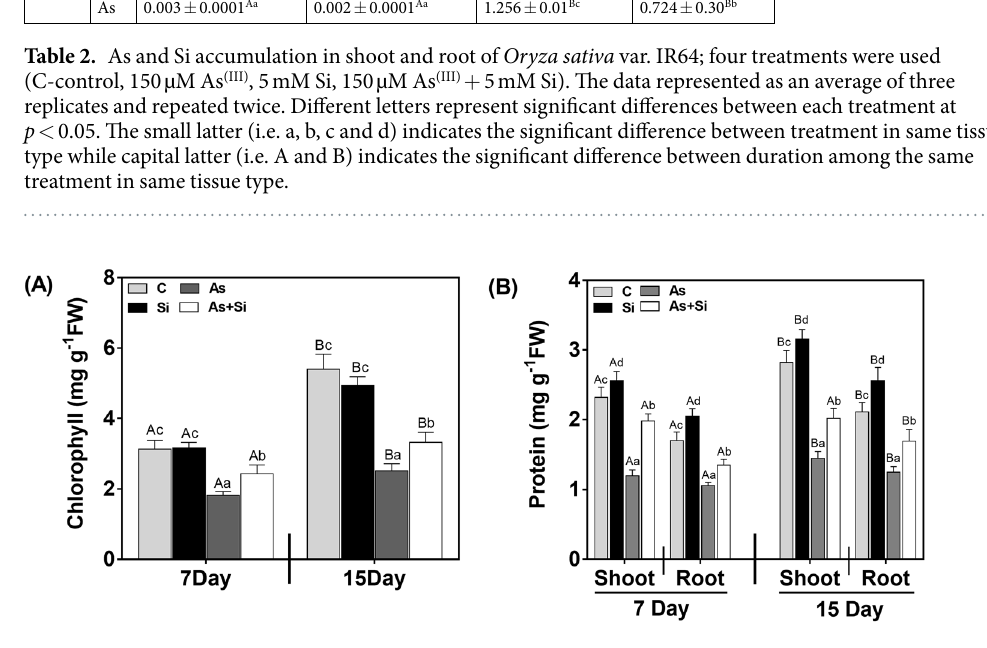
Figure 1. Effect of Si supplementation on ( A ) chlorophyll ( B ) protein content in shoot and roots of Oryza sativa var. IR64 at 7 and 15 d under As (III) stress. All values are means of three replicates (n = 3, ± SD) and repeated twice. Different letters indicate significant mean difference ( p < 0.05) between each treatment. The small latter (i.e. a, b, c and d) indicates the significant difference between treatment in same tissue type while capital latter (i.e. A and B) indicates the significant difference between duration among the same treatment in same tissue type.